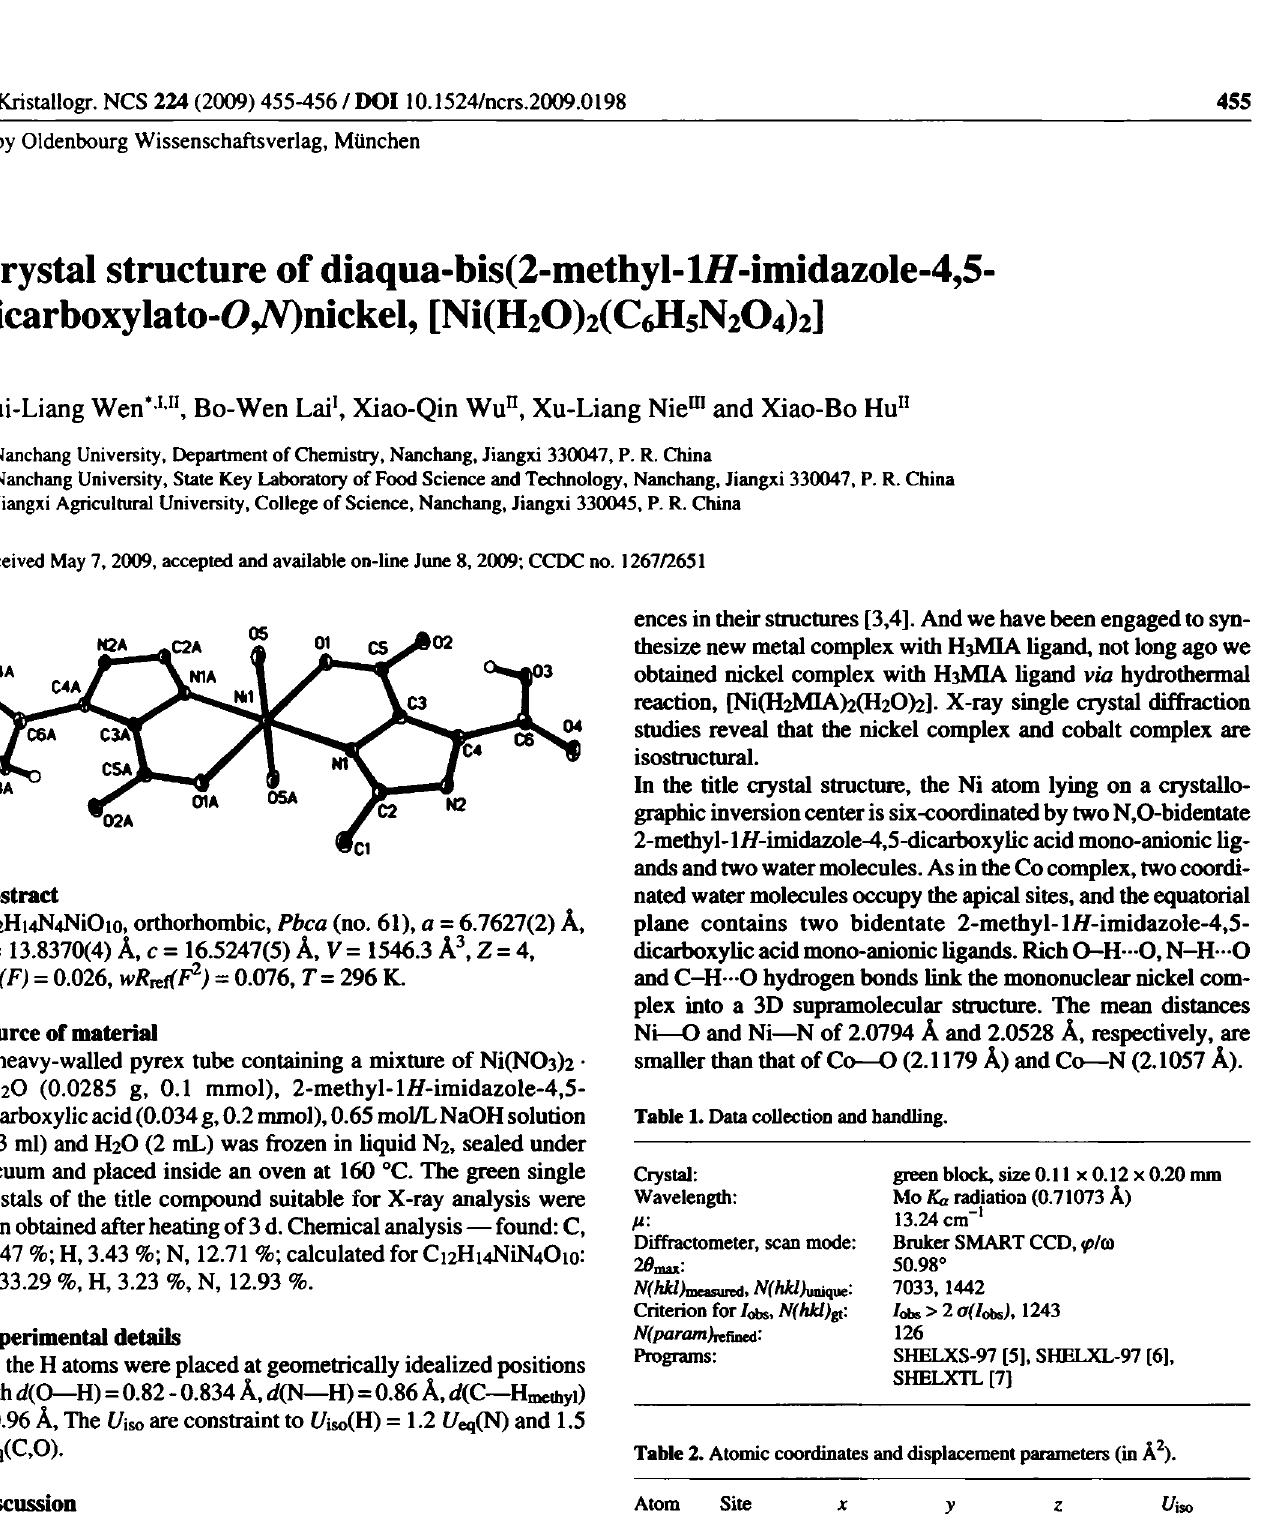
Table 2. Atomic coordinates and displacement parameters (in Â 2